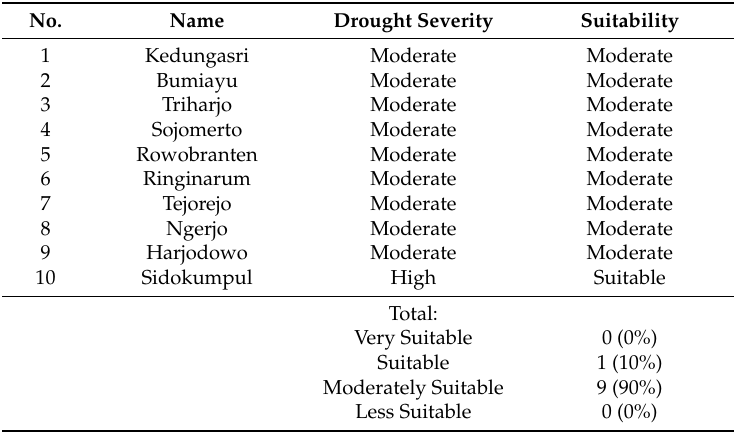
Table 6. Location suitability of the constructed small reservoirs.